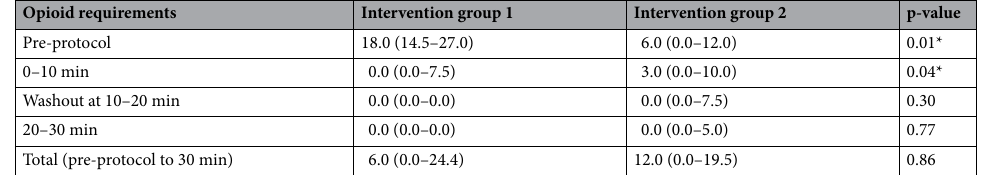
Opioid requirements Intervention group 1 Intervention group 2 p-value